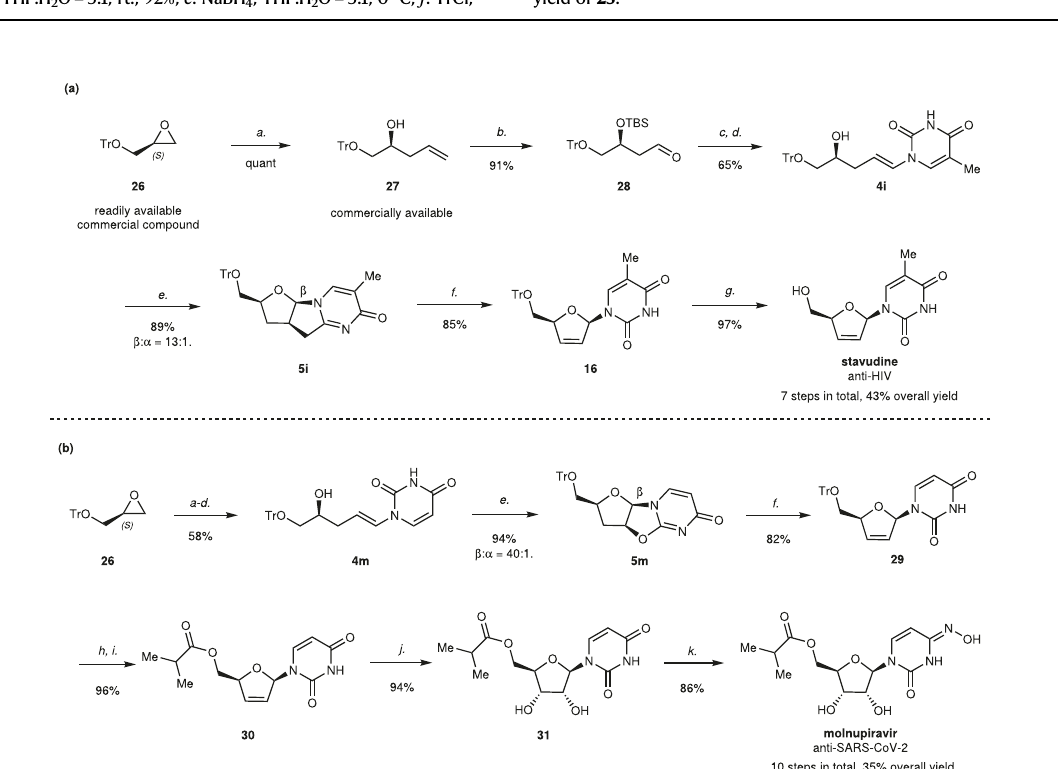
pyridine, DMAP, CH 2 Cl 2 , re fl ux; g. t -BuOK, DMSO, rt., 60% over three steps; h . 80% AcOH aq., 50°C, 95%; i . OsO 4 , NMO, acetone:H 2 O=4:1, rt., 62% yield of 24 , 30% yield of 25 .